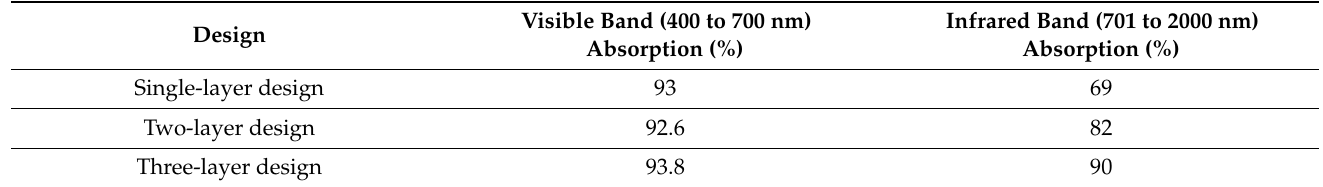
Table 1. Absorption comparison for visible and infrared